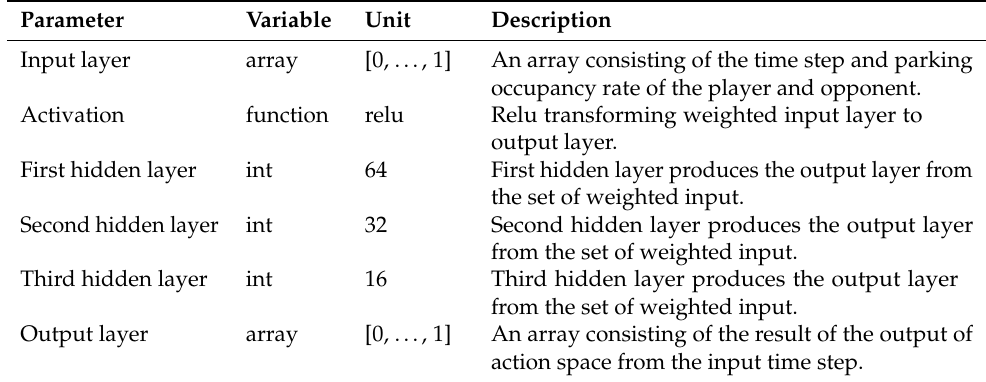
Table 2. Parameters used in the DNN